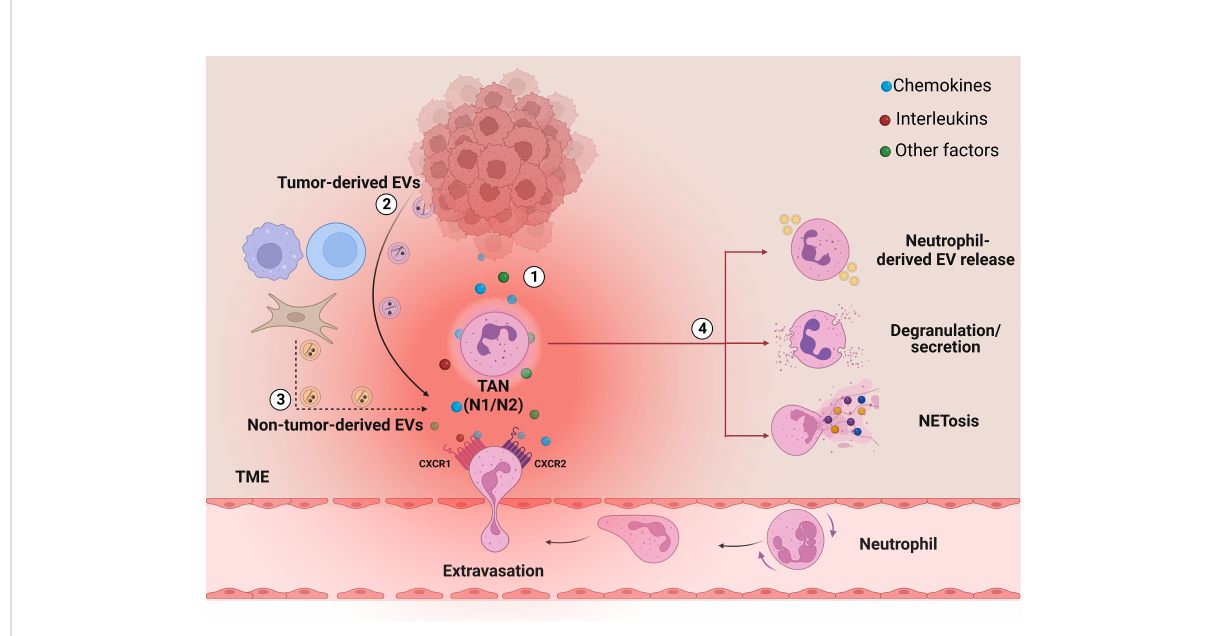
FIGURE 1 The role of secreted factors and EVs in neutrophil recruitment and activation into the TME. In TME, cancer cells can regulate neutrophil biology through the secretion of several factors, among which (1) interleukins and chemokines, such as IL-8, and (2) tumor-derived EVs. These factors regulate the recruitment of the neutrophils from the bloodstream to the tumor and the generation of TANs, which in turn promote cancer progression, metastasis and drug resistance through different cell mechanisms: release of neutrophil-derived EVs, degranulation/secretion and NETosis (4). Together with cancer cells, also other cell types in the TME can release vesicles, which are also potentially able to act on neutrophils (3, dashed arrows). Image created with